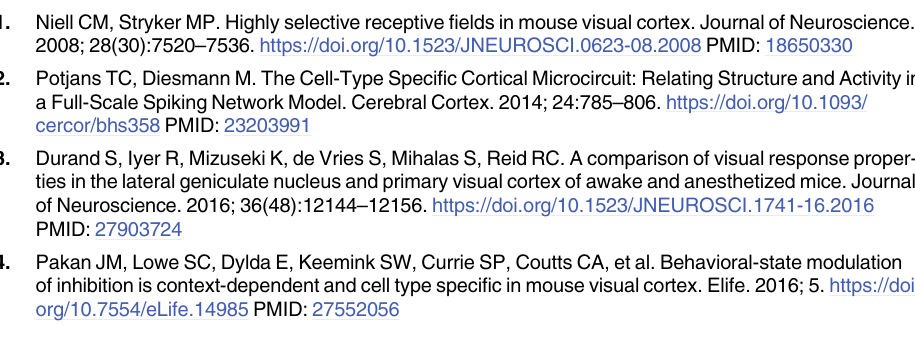
modes, respectively (cf. Fig 7D). S10 Fig. Comparison of orientation selectivity measures. Left column: Distribution of orien- tation selectivity measure based on circular statistics (OSI). Middle column: Orientation selec- tivity measure based on cosine fit (OSI � ). Right column: Comparison of the two orientation selectivity measures. Each dot represents a single neuron in the respective population. S11 Fig. Model comparison. Comparison of the three central observables of the different net- work models. Top row: single neuron firing rates, middle row: preferred orientation (PO), bot- tom row: orientation selectivity index (OSI). The first column compares the spiking network model (Model A) with the firing rate model (Model B), the second column compares the firing rate model with linearized network model (Model C) and the third column compares the spik- ing network model with the linearized network model. Same color code is used as in previous figures to indicate the eight different